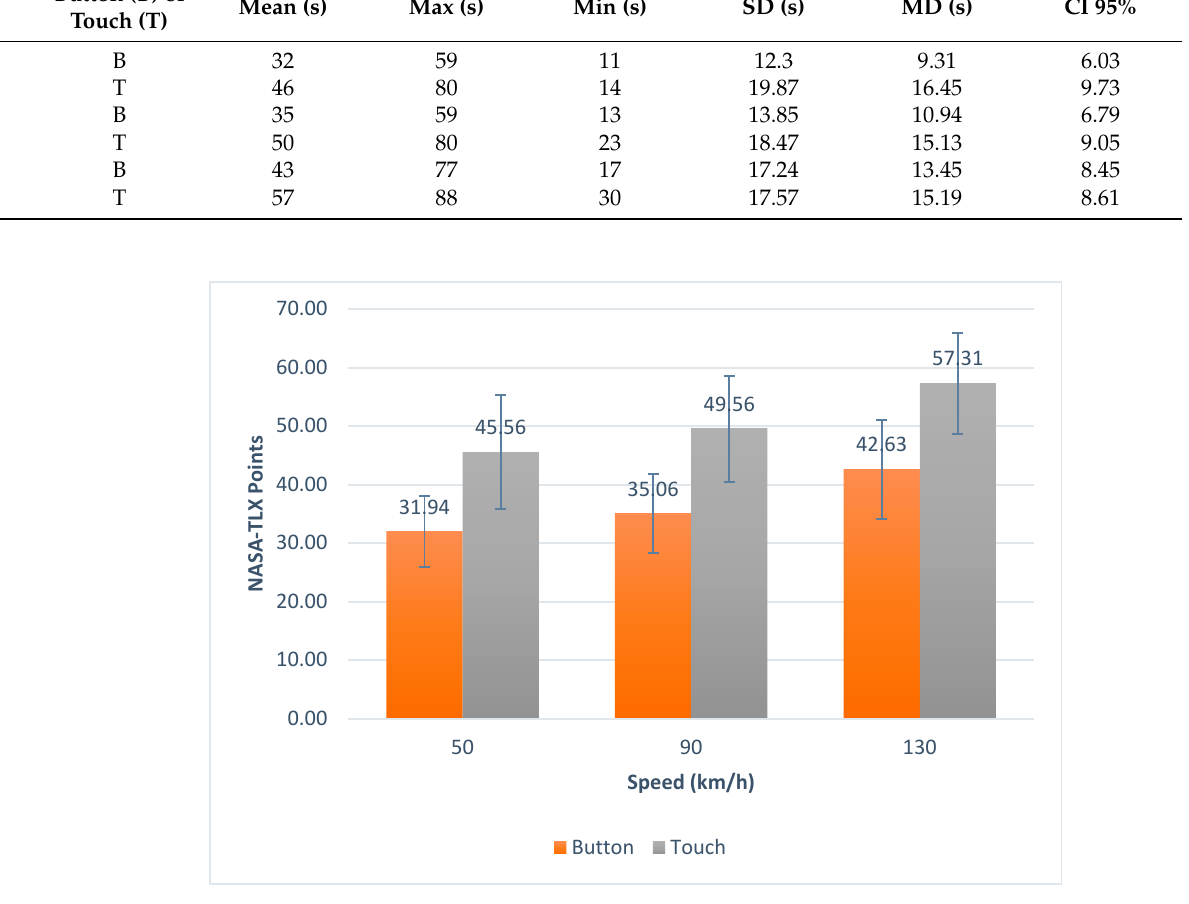
Figure 8. NASA-TLX results. Error bars denote CI (95%).